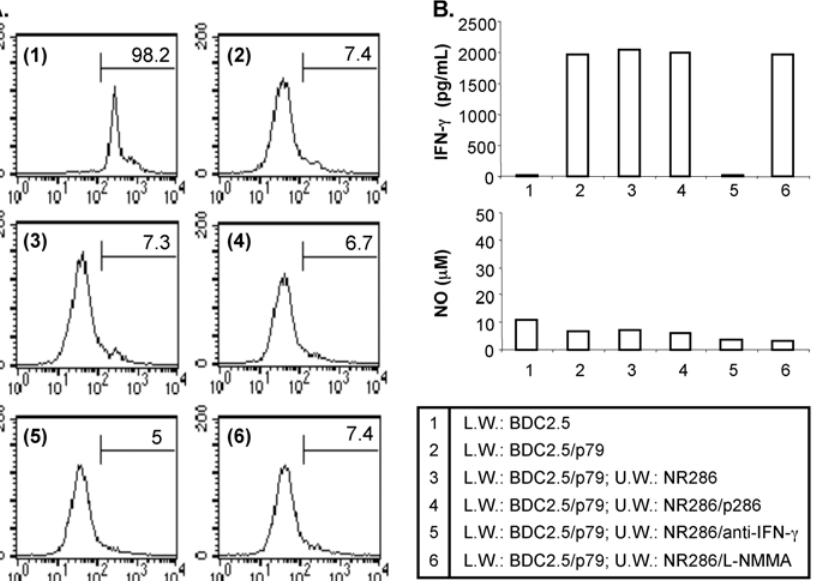
Figure 6. Inhibition of BDC2.5 T cell proliferation is cell contact dependent. ( A ) Transwell analyses of BDC2.5 T cell proliferation. CD4 + BDC2.5 T cells were isolated from BDC2.5 TCR transgenic mice and labeled with CFSE (5 6 10 5 /well). BDC2.5 T cells were cultured either (1) alone or (2) activated with p79 in the transwell lower well (L.W.). In the upper wells (U.W.), an equal number of (3) NR286 T cells alone, (4) NR286 T cells plus p286, or NR286 T cells in the presence of either (5) anti-IFN- c or (6) the active NO inhibitor L-NMMA were cultured for 4 days. The CFSE-labeled BDC2.5 T cells (L.W.) were harvested and cell proliferation analyzed by FACS. Data are from at least 2 experiments. ( B ) Cell culture supernatants obtained from the six cell culture conditions were harvested for analysis of IFN- c and NO